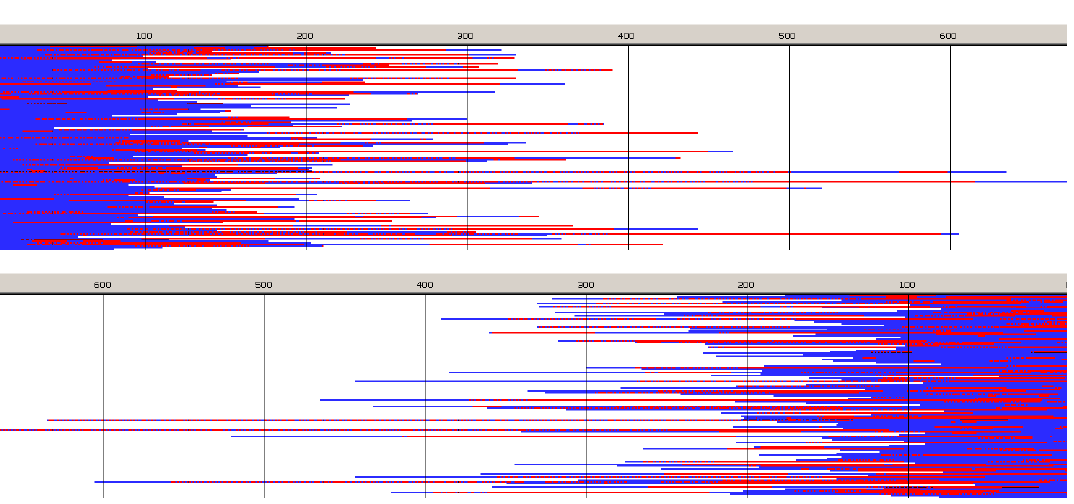
Figure 10. Sets of simulated copolymer chains in copolymerization initiated with the mixture of R - and S - Ini (94:6). Reactivity ratios as given in Table 2, z LLR = 6.92, z LLS = 1.45, and the ratio of Tmc homopropagation rate constants, k TTR / k TTS, being about 0.78. [ Tmc ] 0 = 2, [ Lac ] 0 = 1.2 mol · L − 1 , and [ Ini ] 0 = 5 × 10 − 3 (+[ i PrOH] 0 = 1 × 10 − 2 , due to in situ synthesis of Ini ), Conversion 95%, DP n = 202.1, Ð = 1.27, average number of homoblocks in a chain equal to 25.2.